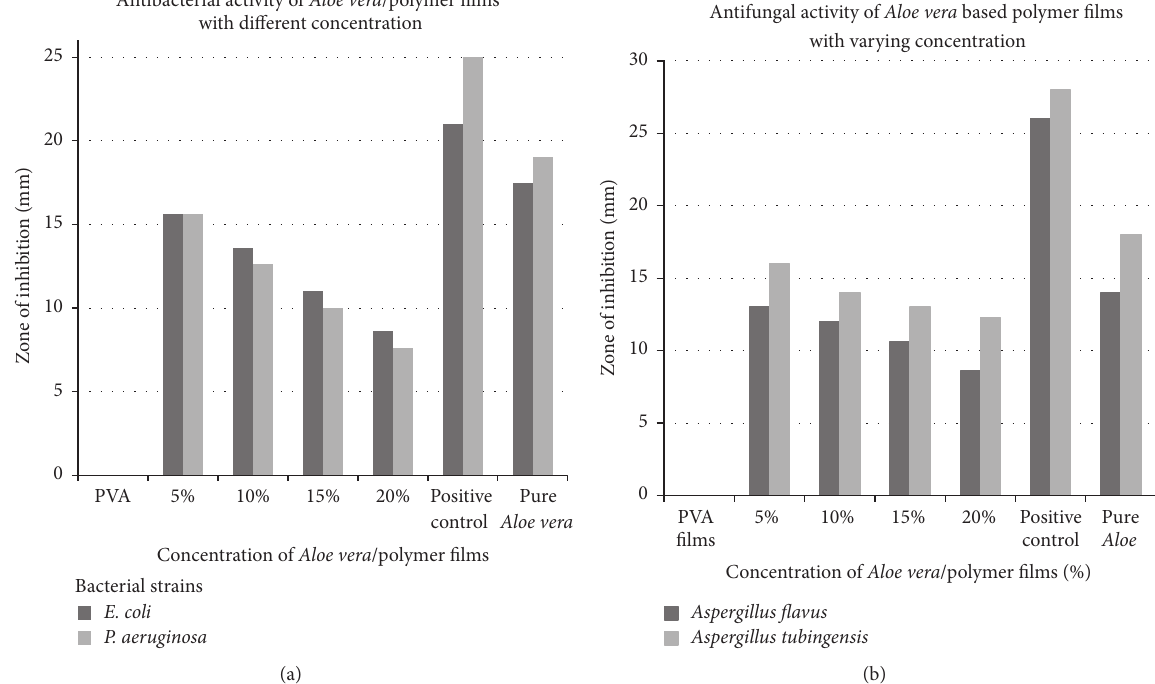
Figure 3: Graphical representation of antibacterial (a) and antifungal (b) activity of different concentrations of Aloe vera /polymer films. 𝑦 -axis shows zones in mm while 𝑥 -axis shows varying concentration of Aloe vera /polymer